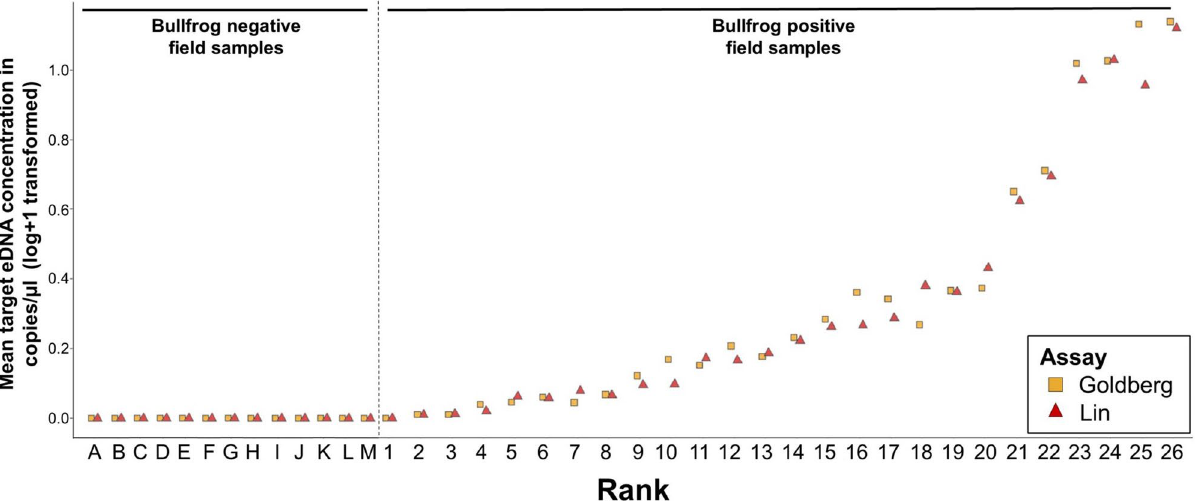
Figure 2. Mean bullfrog eDNA concentrations of field-collected samples quantified with the Goldberg and Lin primer/probes for the in situ evaluation of specificity (ranks A–M) and sensitivity (ranks 1–26). Samples corresponding to ranks A to M were collected from water bodies free from bullfrogs, but harboring the most common co-occurring amphibian species native to Western Europe (see Supplementary Table S1). Ranks 1 (~ 0.025 copies/µL) to 25 (~ 12.45 copies/µL) reflect a ranking of increasing mean bullfrog eDNA concentrations of samples collected from natural water bodies. Rank 26 represents a bullfrog tissue sample functioning as a positive reference in this study. Per sample, the mean log + 1-transformed eDNA concentrations expressed as copies per µL of three technical replicates are plotted as orange squares for the Goldberg and as red triangles for the Lin assay.